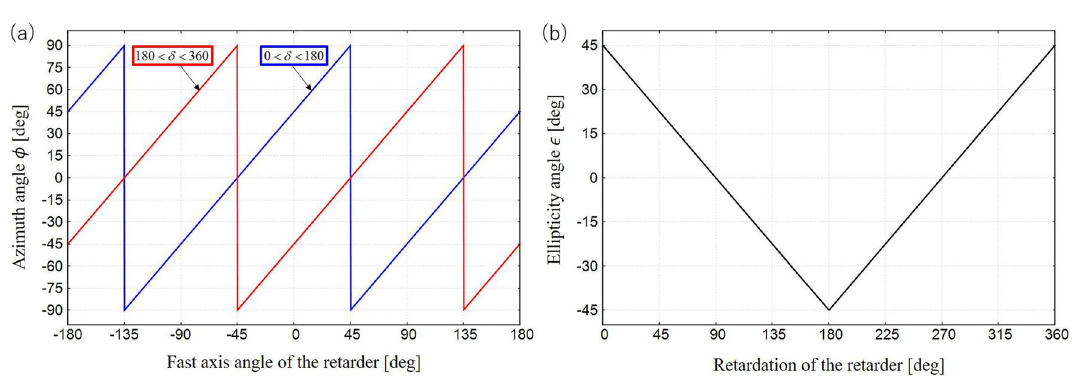
Figure 6. Numerically calculated ( a ) azimuth and ( b ) ellipticity angle plotted as functions of fast axis and retardation of the retarder.